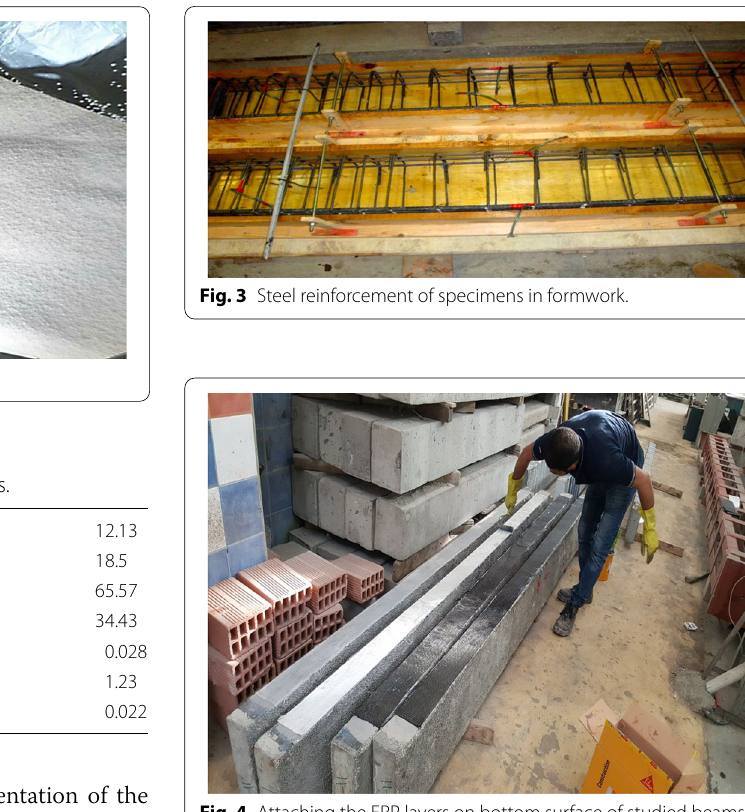
Fig. 4 Attaching the FRP layers on bottom surface of studied